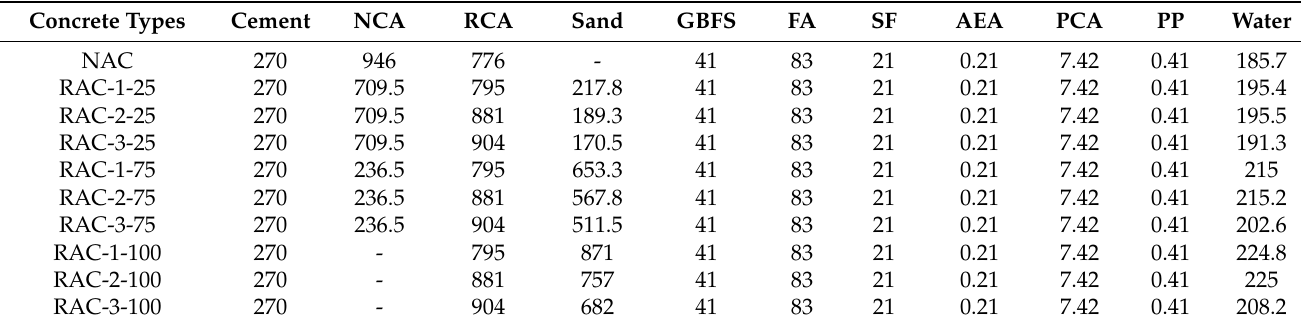
Table 1. Mixed proportions of NAC and RRAC.